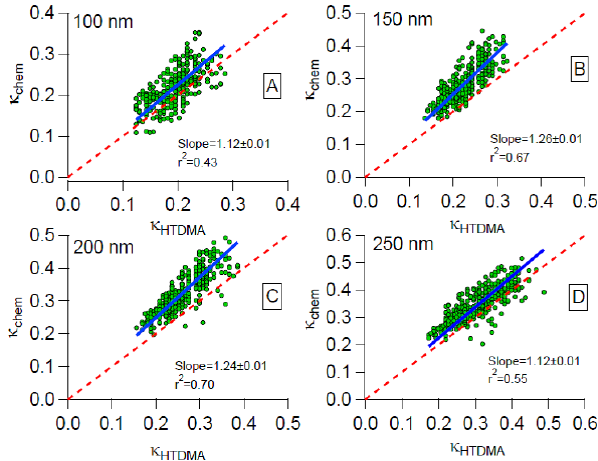
Figure 22. Comparison between κ chem (calculated using size- resolved aerosol compositions) and κ htdma (derived from H-TDMA measurements) for aerosol particles with dry diameters of (a) 100, (b) 150, (c) 200 and (d) 250nm. Reprint with permission by Wu et al.